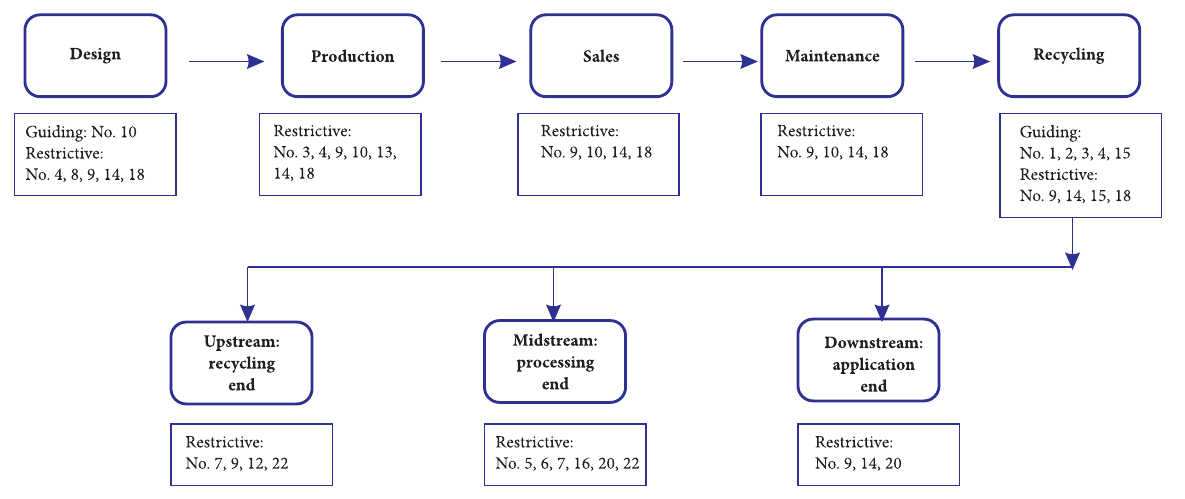
Figure 2. Life cycle policies for power batteries